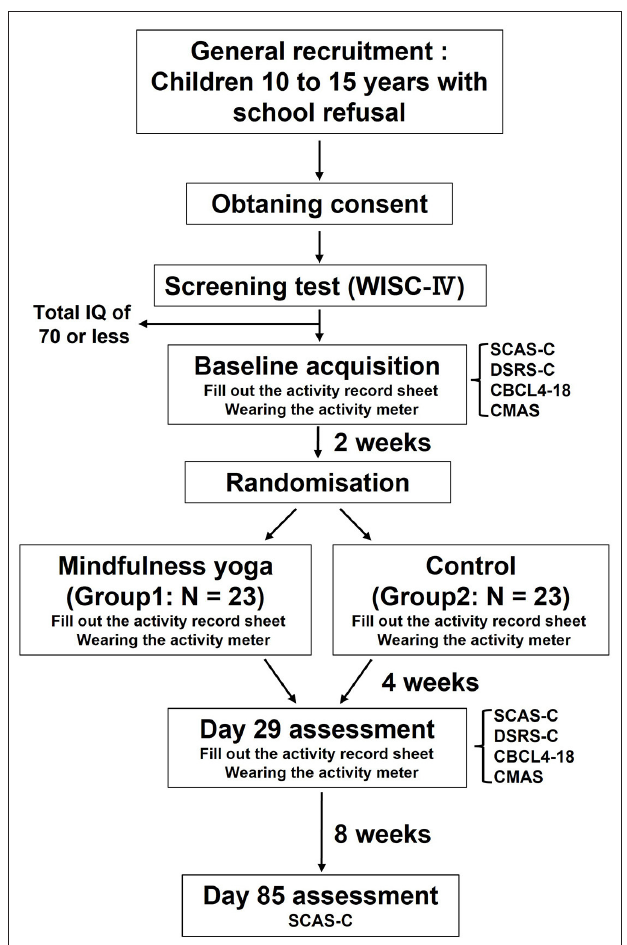
FIGURE 1 | Flowchart of the study schedule. WISC-IV, Wechsler Intelligence Scale for Children, Fourth Edition; SCAS-C, Spence Children’s Anxiety Scale–Children; DSRS-C, Depression Self Rating Scale for Children; CBCL-4–18, Child Behavior Checklist for ages 4–18; CMAS, Children’s Manifest Anxiety